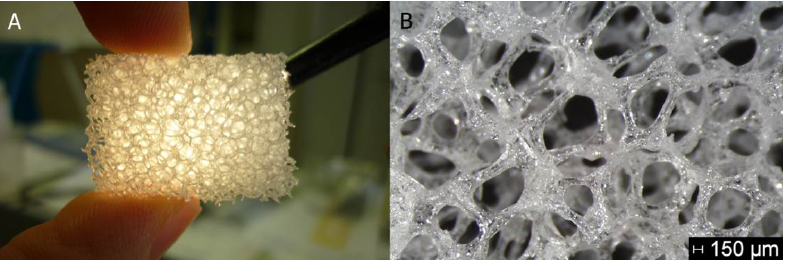
Figure 3. Photograph ( A ) and high-resolution image ( B ) of a transparent sponge show deep and homogeneous light transmissions in the glass structure. Reprinted/adapted with permission from Ref. [2]. Copyright 2012 Jacobi A, et